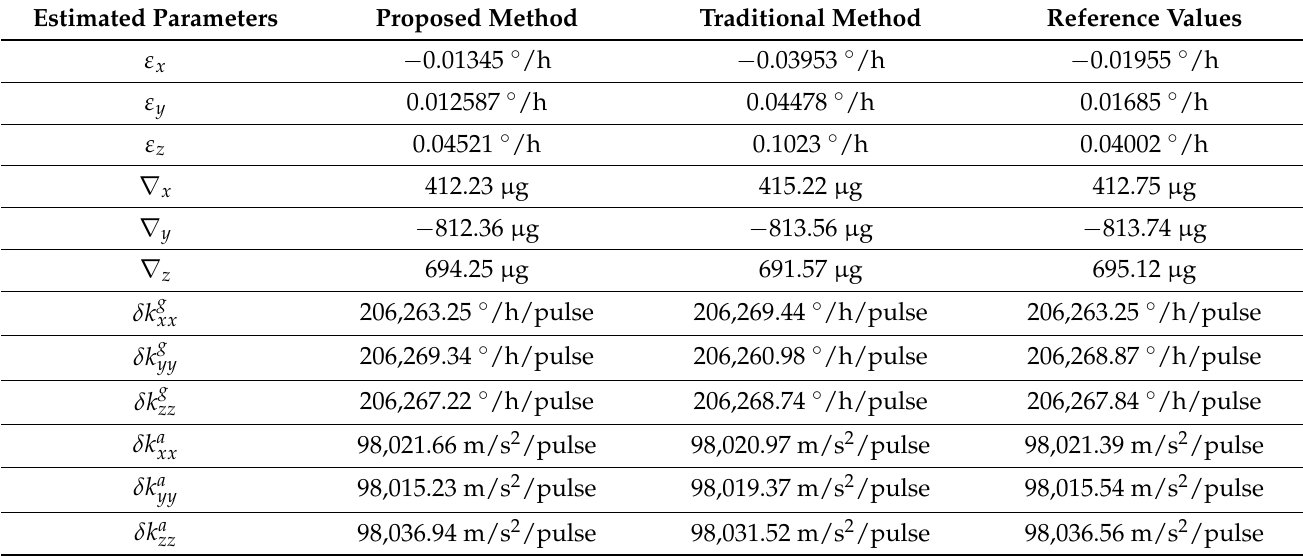
Table 4. Estimation results of different